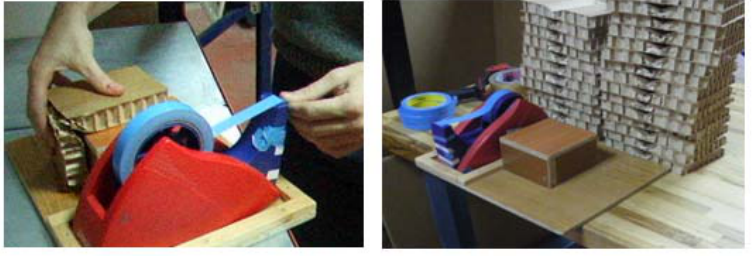
Figure 2. Poya-Yoke designed for bending protectors in